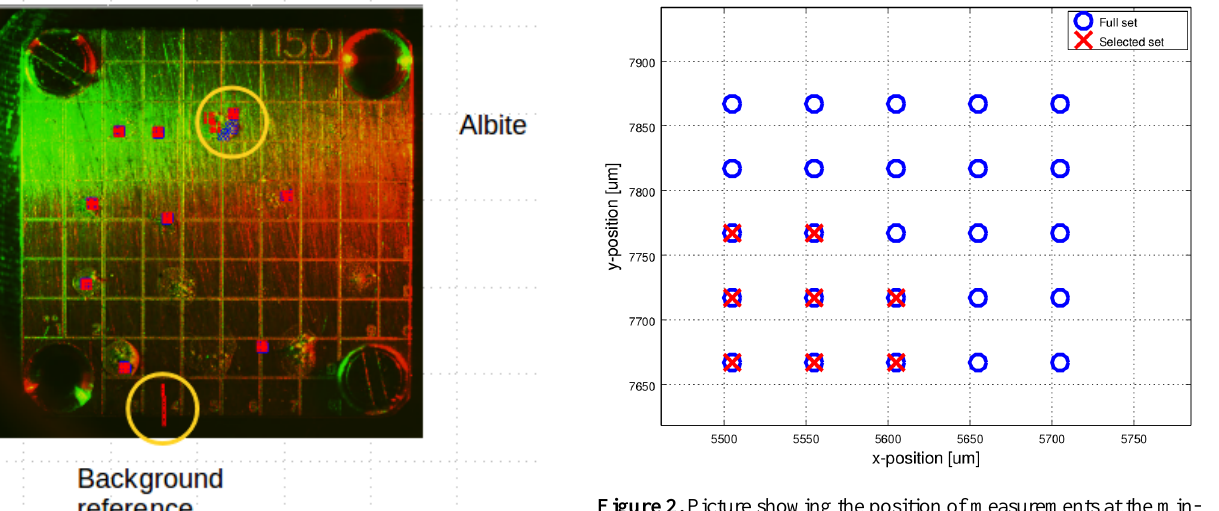
Figure 2. Picture showing the position of measurements at the min- eral albite. The beam radius corresponds to the distance between the indicated positions. The marked squares indicate the hand picked positions on the edge of the mineral sample. As the sample is placed by wet deposition, it is likely that the other positions are contami- nated by the same mineral substance in a possibly diluted